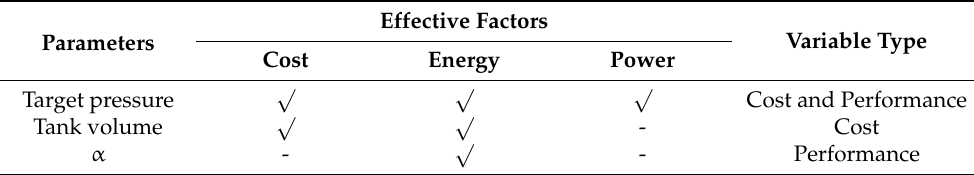
Table 1. Various parameters affect power, energy, and cost capacities.